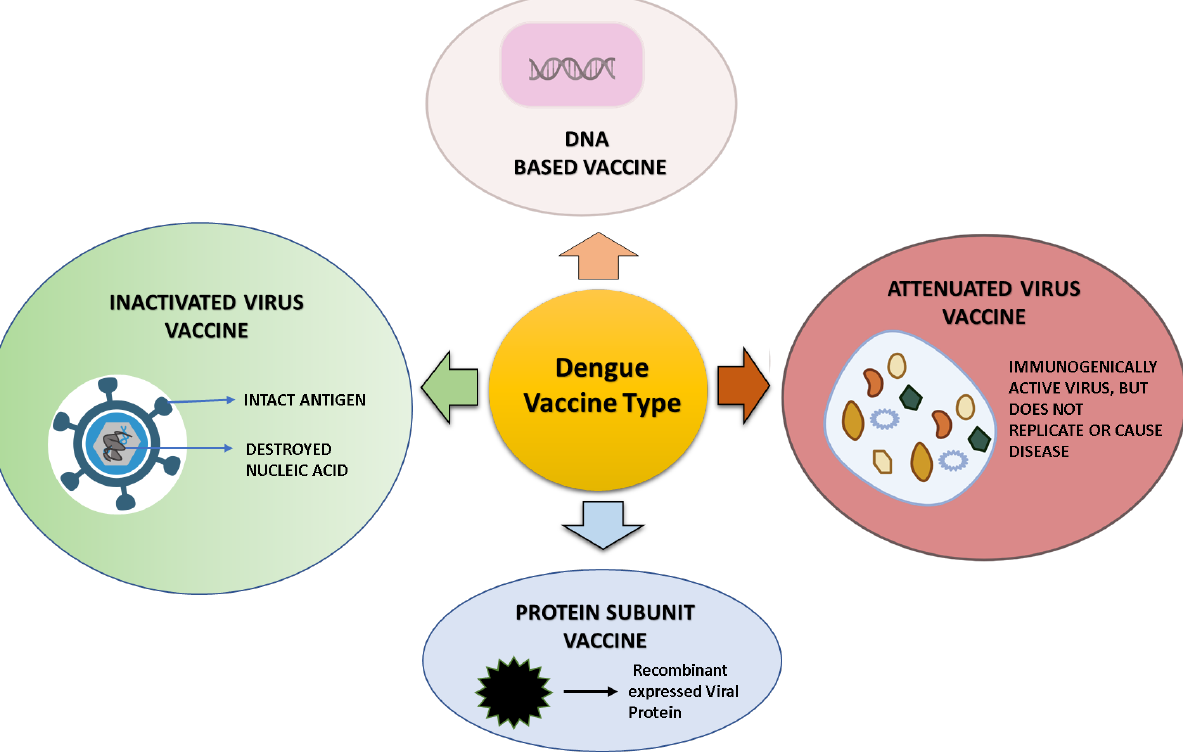
Figure 5. Dengue vaccine platform: Vaccines against the dengue virus have been developed using a range of platforms and funded by private companies as well as government agencies.